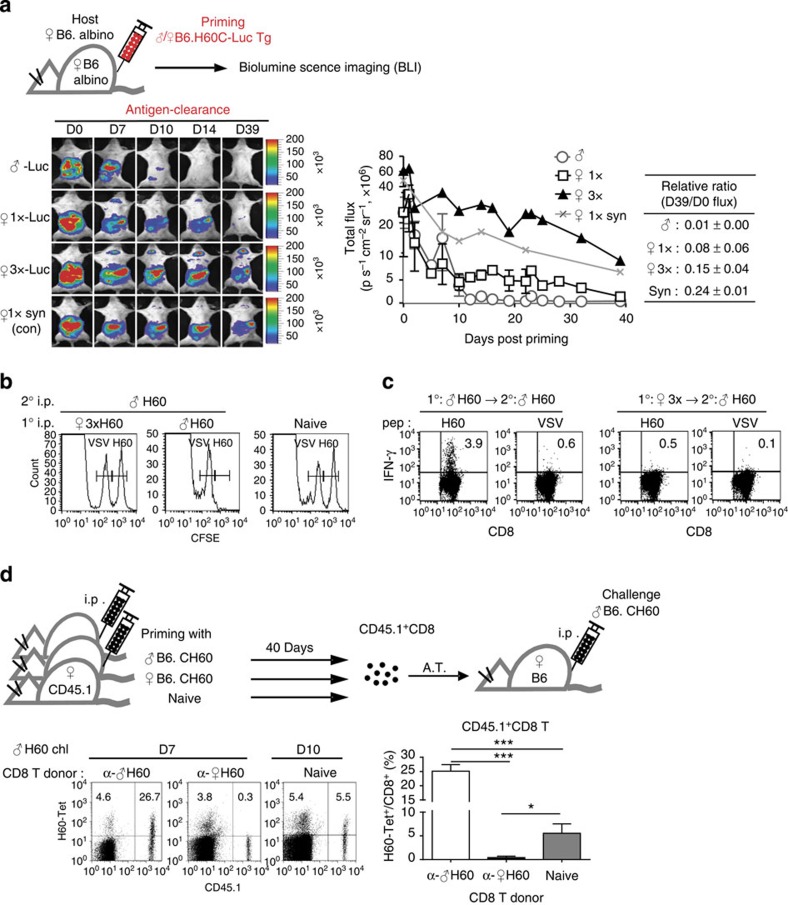
Ineffective antigen clearance and CD8+ T-cell-intrinsic memory impairment under helper-deficient conditions.(a) In vivo imaging of H60 allografts (B6.CH60-LucTg cells). Female B6-Albino hosts were i.p. injected with female or male B6.CH60-LucTg cells, and bioluminescence images were captured periodically. Female B6.CH60-Albino hosts were primed with B6.CH60-LucTg cells as syngeneic controls. The whole body was designated as the region of interest (ROI), and the photon flux outcomes from the ROIs along the response progress were plotted. The mean relative ratios of day 39: day 0 photon flux values are presented in the table. (b) In vivo cytotoxicity assay. Mixtures (1:1) of the CFSE-labelled and peptide-loaded target cells (2.5 μM CFSE-labelled and H60-loaded versus 0.42 μM CFSE-labelled and VSV-loaded) were i.v. injected into each group of mice and analysed 72 h later by flow cytometry of the PBLs for detection of the CFSE-labelled cells. (c) Specific IFN-γ production was assessed in splenocytes harvested from tolerized-and-boosted or helped-and-boosted hosts on day 7 post boosting. (d) CD45.1+ female B6 mice were primed with female or male B6.CH60 splenocytes 40 days previously. Then, CD8+ T cells (3 × 106) purified from these differently primed CD45.1+ mice or those purified from unprimed naive CD45.1+ mice were adoptively transferred (A.T.) to naive female CD45.2+ B6 mice. Then, the naive adoptive hosts were challenged with male B6.CH60 splenocytes. PBLs were longitudinally analysed after gating on CD8+ cells. Representative flow cytometric data obtained on day 7 or 10 post challenge are presented. Proportions of H60-Tet+ cells in CD45.1+ and CD45.1− CD8+ cells are denoted in the upper quadrants and the percentage values in the CD45.1+CD8+ cells are plotted. Representative data from more than three independent experiments (n=3 per group per experiment) are shown (a–d). Data are presented as means±s.e.m. *P<0.05, ***P<0.001 determined by Student's t-test.